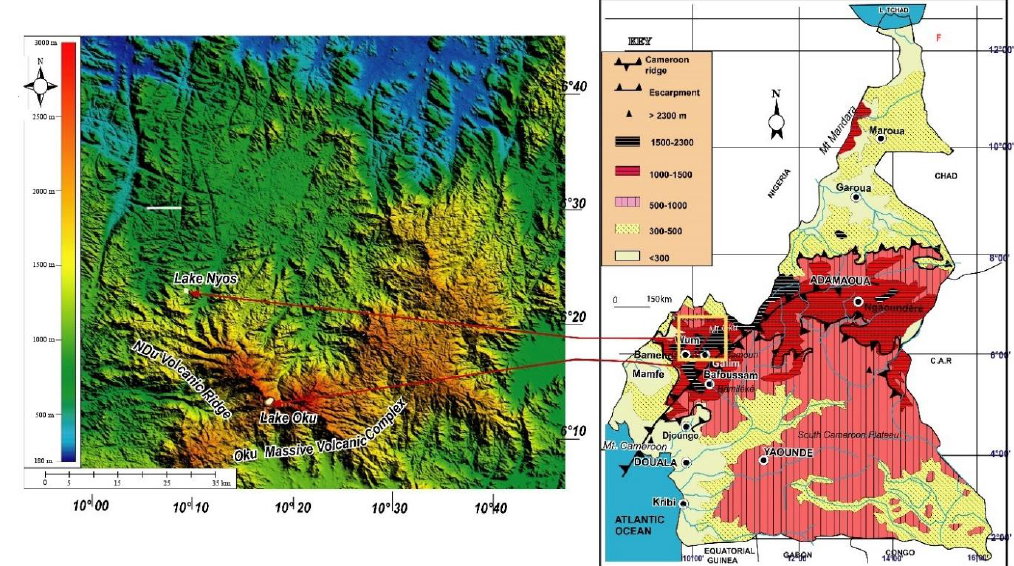
Figure 1. Topographic maps (SRTM data, left ) showing the location Lake Nyos (N06E010.Hgt). On the right , the main geomorphological units (5) characterizing the Cameroonian relief: coastal plain (300 m a.s.l.), lower plateau (300–500 m a.s.l.), central plateau (500–1000 m a.s.l.), mountains and hills (1000–1500 m a.s.l.), high mountains and massive volcanoes (more than 1500 m a.s.l.). Lake Nyos,